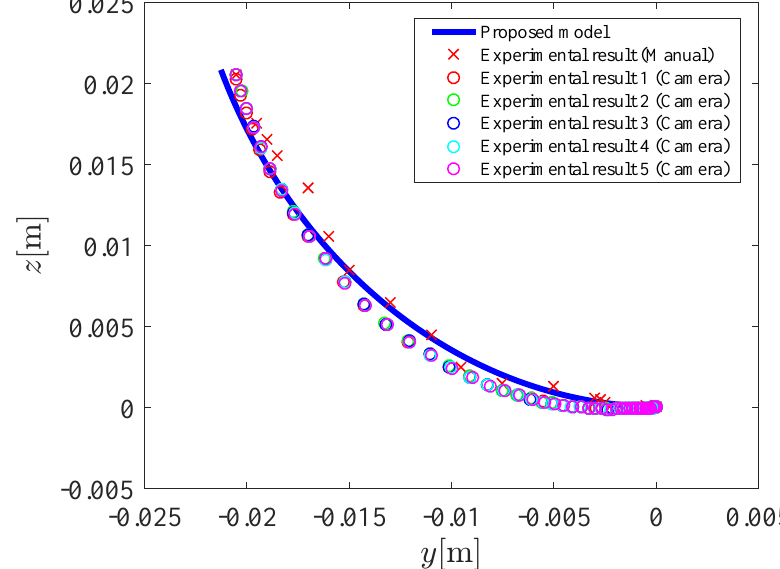
Figure 15. The coordinate values y and z of the tip of the micro-hand ( P 1 = P 2 = 0kPa, P 3 = 0 kPa–250